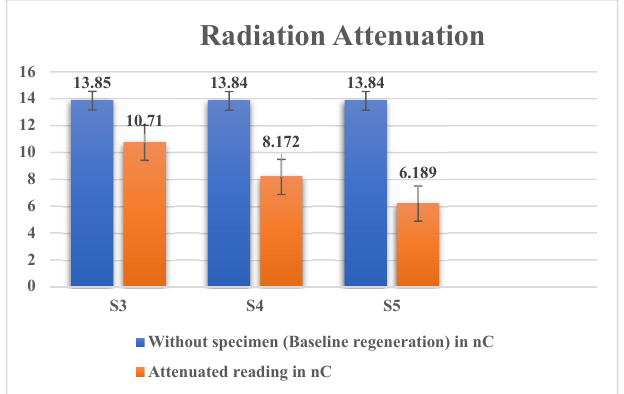
Figure 7. Attenuation for specimens with and without lead oxide reinforcement.